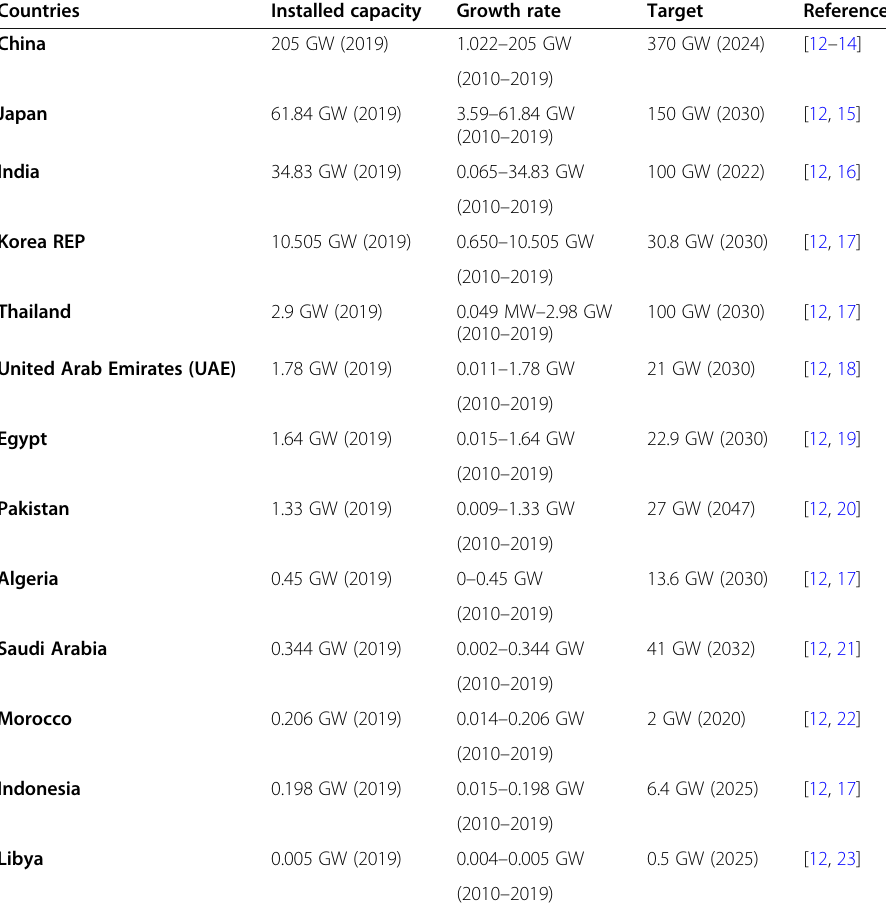
Table 1 Summary of solar capacity in some of the MENA and the Far East countries Countries Installed capacity Growth rate